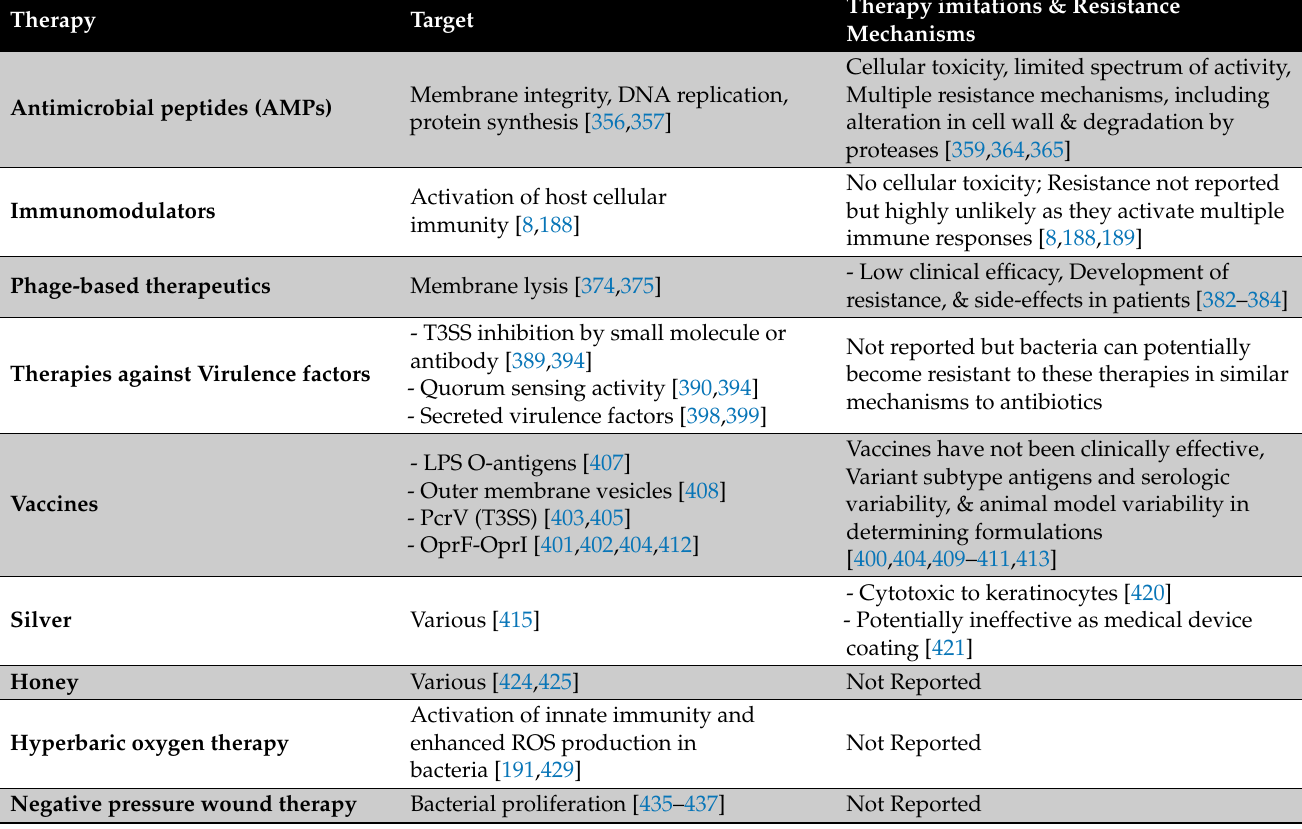
Table 3. Emerging non-antibiotic therapeutics for Pseudomonas aeruginosa